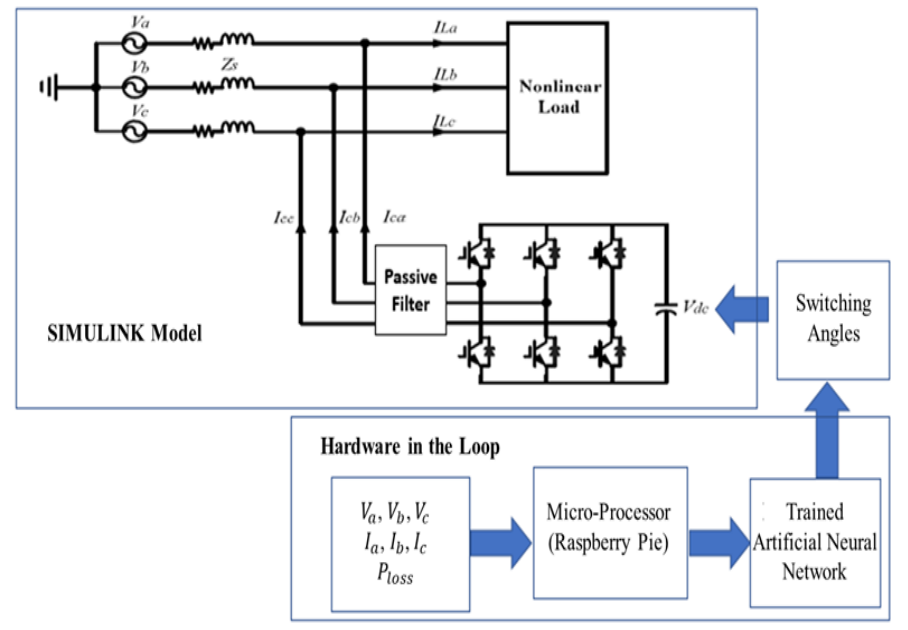
Figure 2. Block Diagram of HSAHPF Configured With HIL.